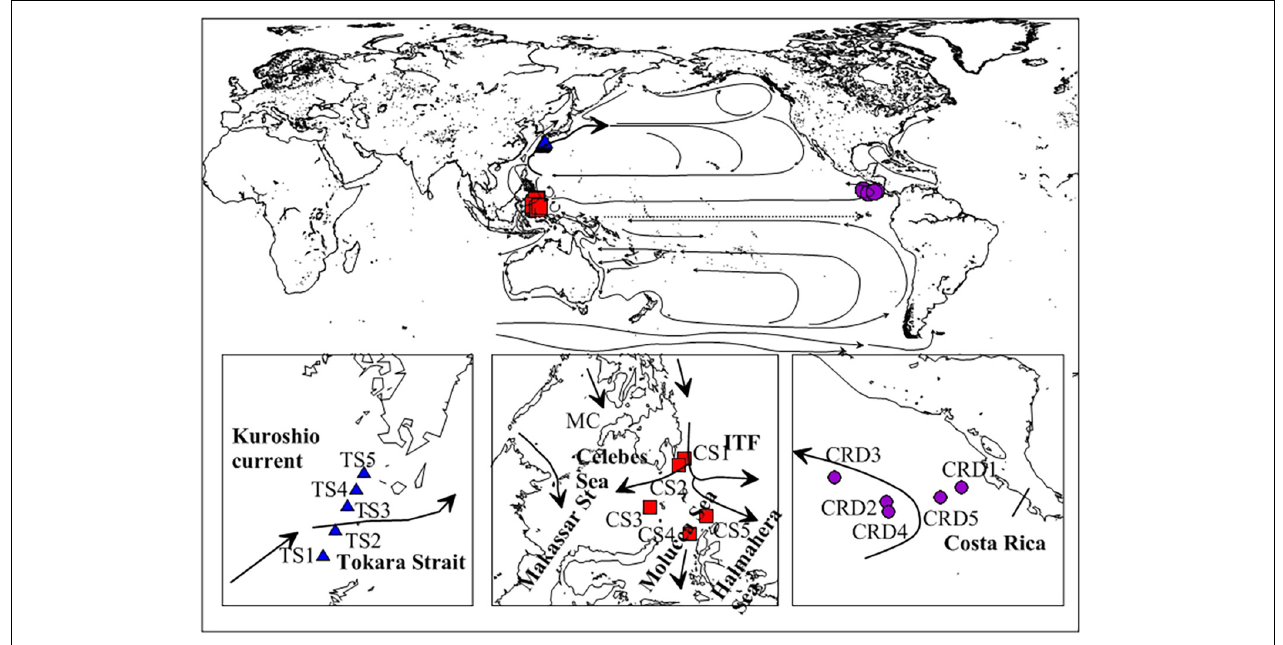
FIGURE 1 | Locations of the sampling stations in three investigated regions around the Pacific Ocean, including Costa Rica Dome (CRD), Celebes Sea (CS), and Tokara Strait (TS; ITF, The Indonesian